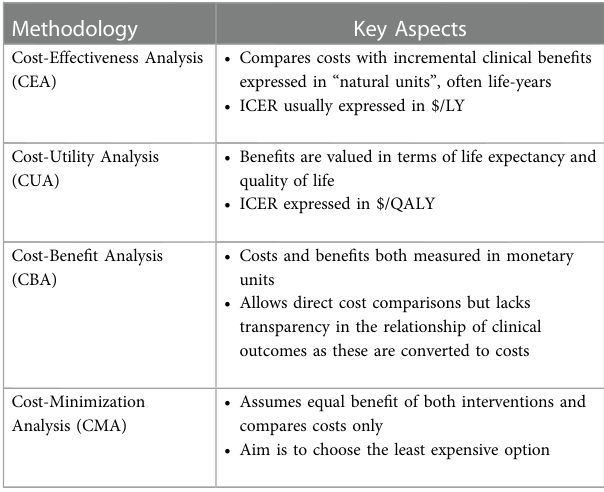
TABLE 1 Key methodologies in health economic